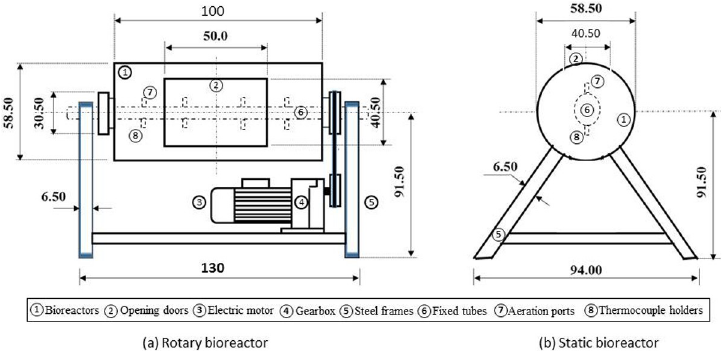
Fig 1. Schematic diagram showing the constructed (a) rotating bioreactor and (b) static bioreactor systems; dimensions in cm, not to scale.